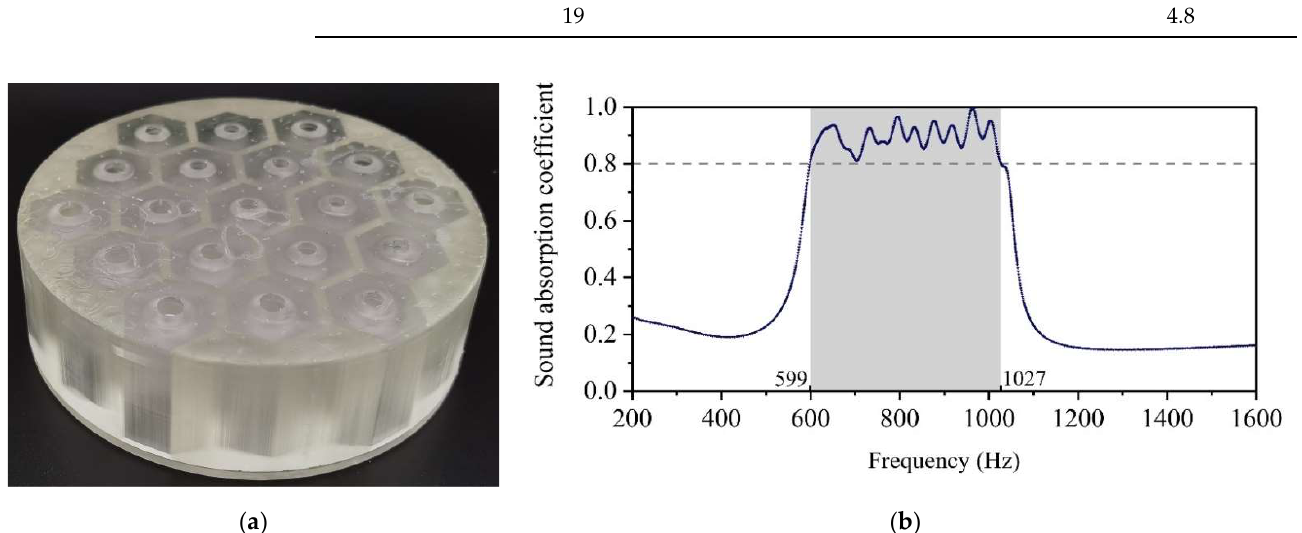
Figure 11. The optimization results of Condition-2. ( a ) Schematic diagram of the 3D printed sample with the diameter of 100 mm and the thickness of 30 mm. ( b ) The corresponding actual sound absorption coefficient.